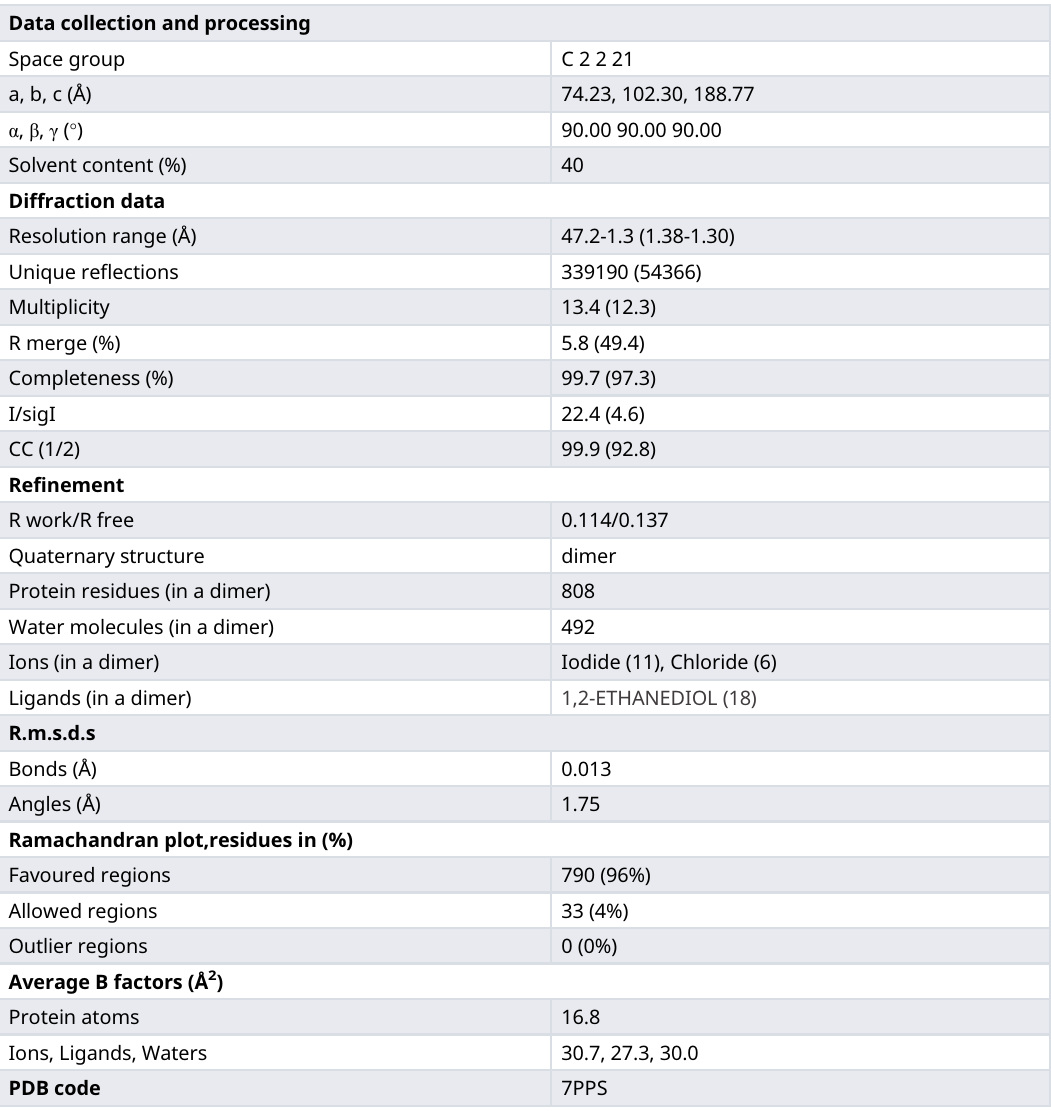
Table 2. Data-collection and refinement statistics of Pa FabB C161A. Values in parentheses are for the highest resolution